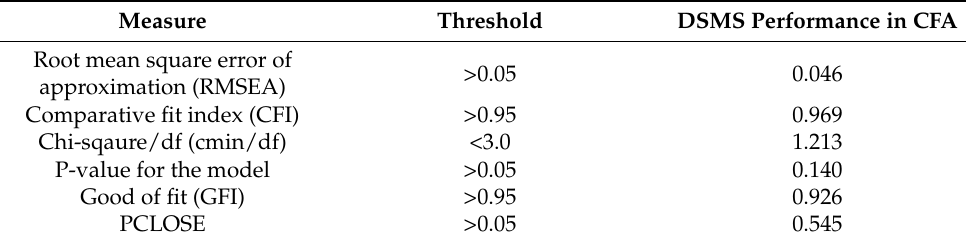
Table 2. Assessment of model fit using AMOS and